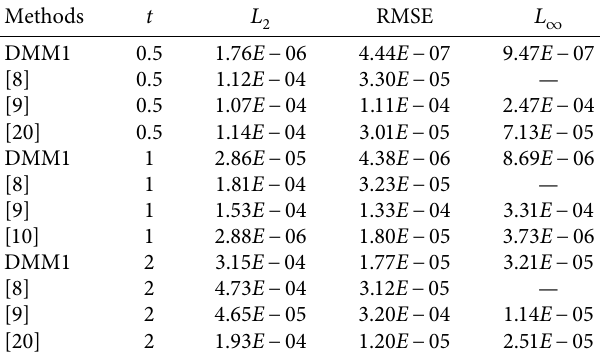
Table 4: Numerical results with α � 10and β � 5 for Example 4.